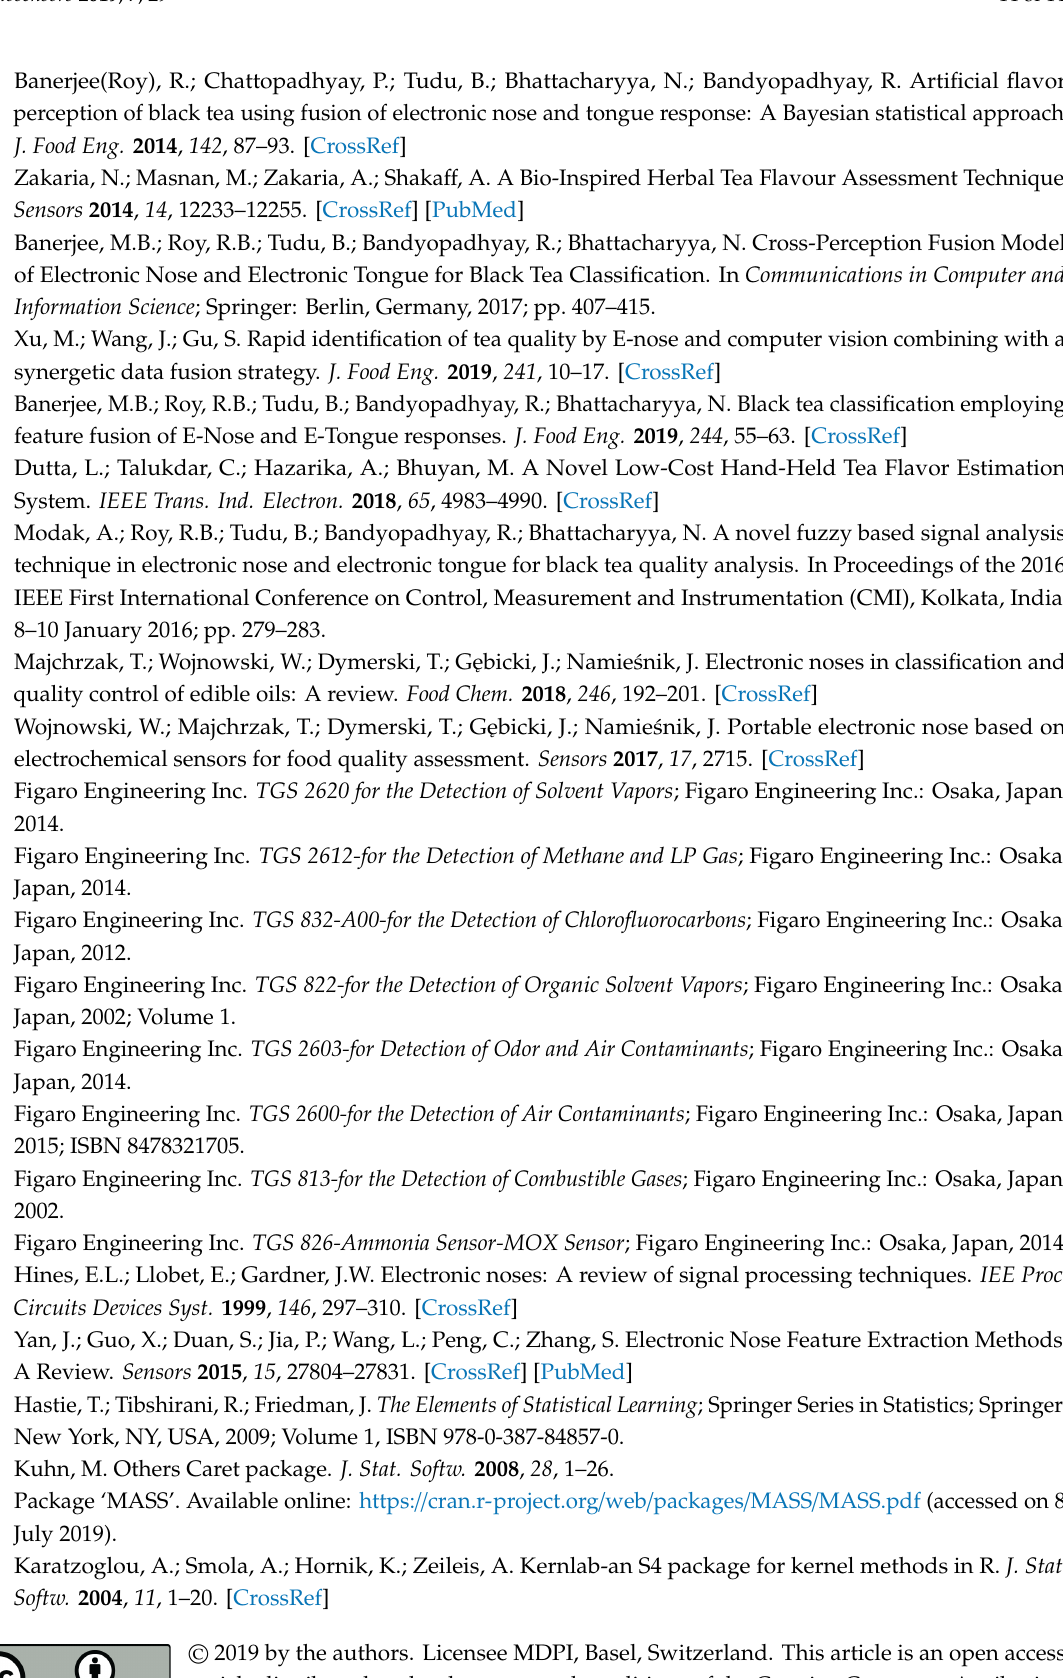
Figaro Engineering Inc. TGS 2620 for the Detection of Solvent Vapors ; Figaro Engineering Inc.: Osaka, Japan, Figaro Engineering Inc. TGS 2612-for the Detection of Methane and LP Gas ; Figaro Engineering Inc.: Osaka, Japan, 2014. Figaro Engineering Inc. TGS 832-A00-for the Detection of Chlorofluorocarbons ; Figaro Engineering Inc.: Osaka, Japan, 2012. Figaro Engineering Inc. TGS 822-for the Detection of Organic Solvent Vapors ; Figaro Engineering Inc.: Osaka, Japan, 2002; Volume 1. Figaro Engineering Inc. TGS 2603-for Detection of Odor and Air Contaminants ; Figaro Engineering Inc.: Osaka, Japan, 2014. Figaro Engineering Inc. TGS 2600-for the Detection of Air Contaminants ; Figaro Engineering Inc.: Osaka, Japan, Figaro Engineering Inc. TGS 813-for the Detection of Combustible Gases ; Figaro Engineering Inc.: Osaka, Japan, Figaro Engineering Inc. TGS 826-Ammonia Sensor-MOX Sensor ; Figaro Engineering Inc.: Osaka, Japan,